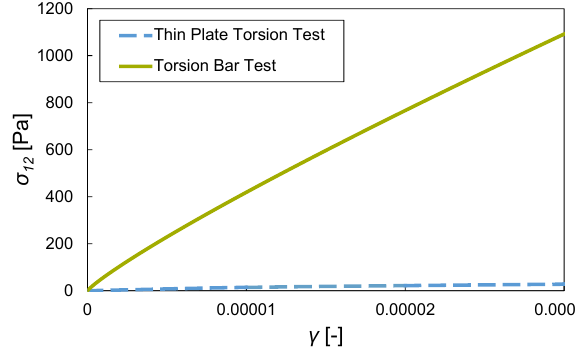
Figure 4: Results – Torsion Bar Test: longitudinal shear stress σ 12 vs. shear strain 𝛾 at 0.005 s −1 for two different temperatures and three different material conditions.